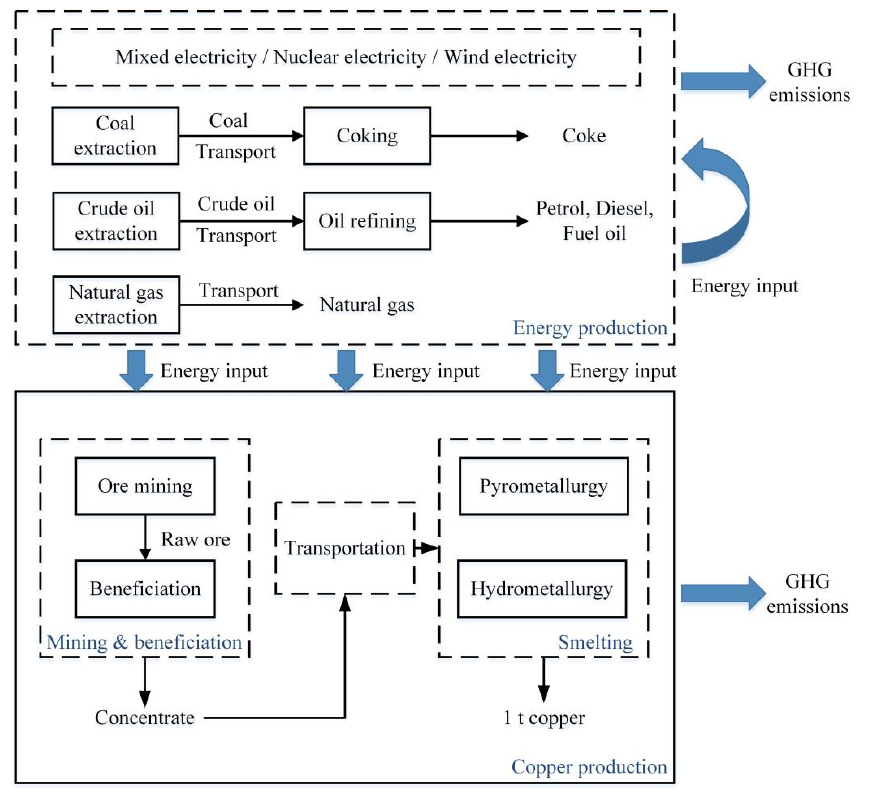
Figure 1. Life cycle boundary of the copper production.